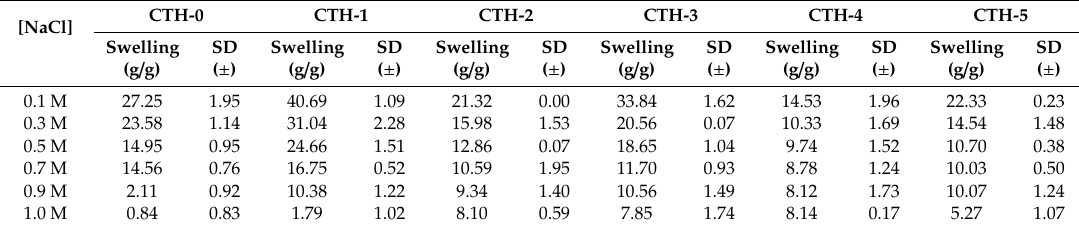
Figure 8. Swelling behaviour of CS/PAH films in different molar concentrations of CaCl 2 solutions. Table 5. Data showing swelling behaviour of CS / PAH films in di ff erent molar concentrations of NaCl.